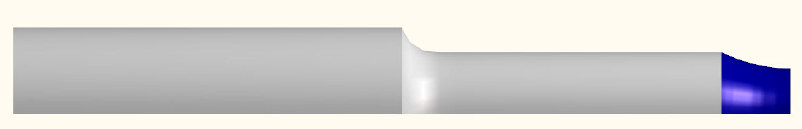
Figure 9. The 3-D model of the specimen for dynamic test highlighting the notch area. Appl. Sci. 2017 , 7 , x